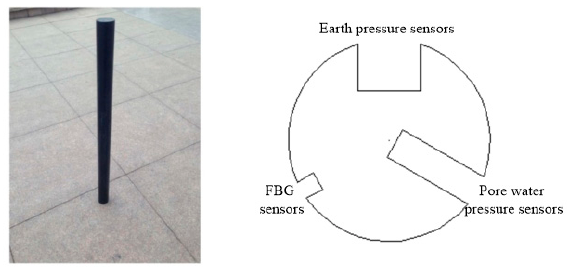
Figure 1. The model pile.